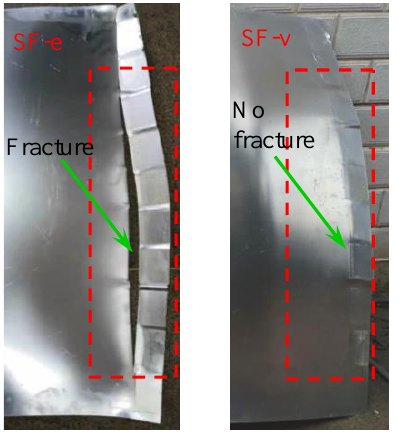
Figure 20. Spherical parts in experiment.